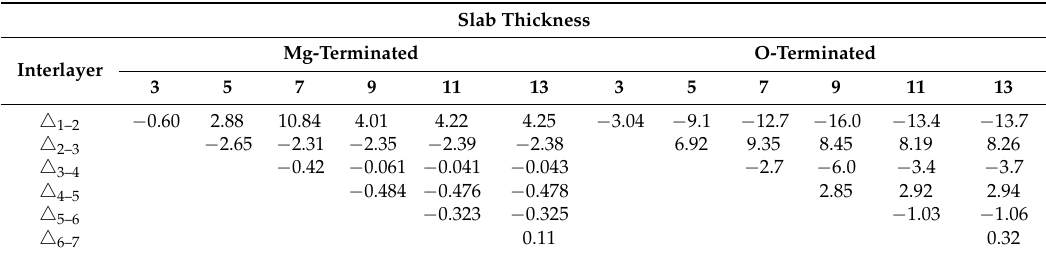
Table 2. Change of interlayer spacing as a percentage of the spacing in the bulk for MgO(111) free surface